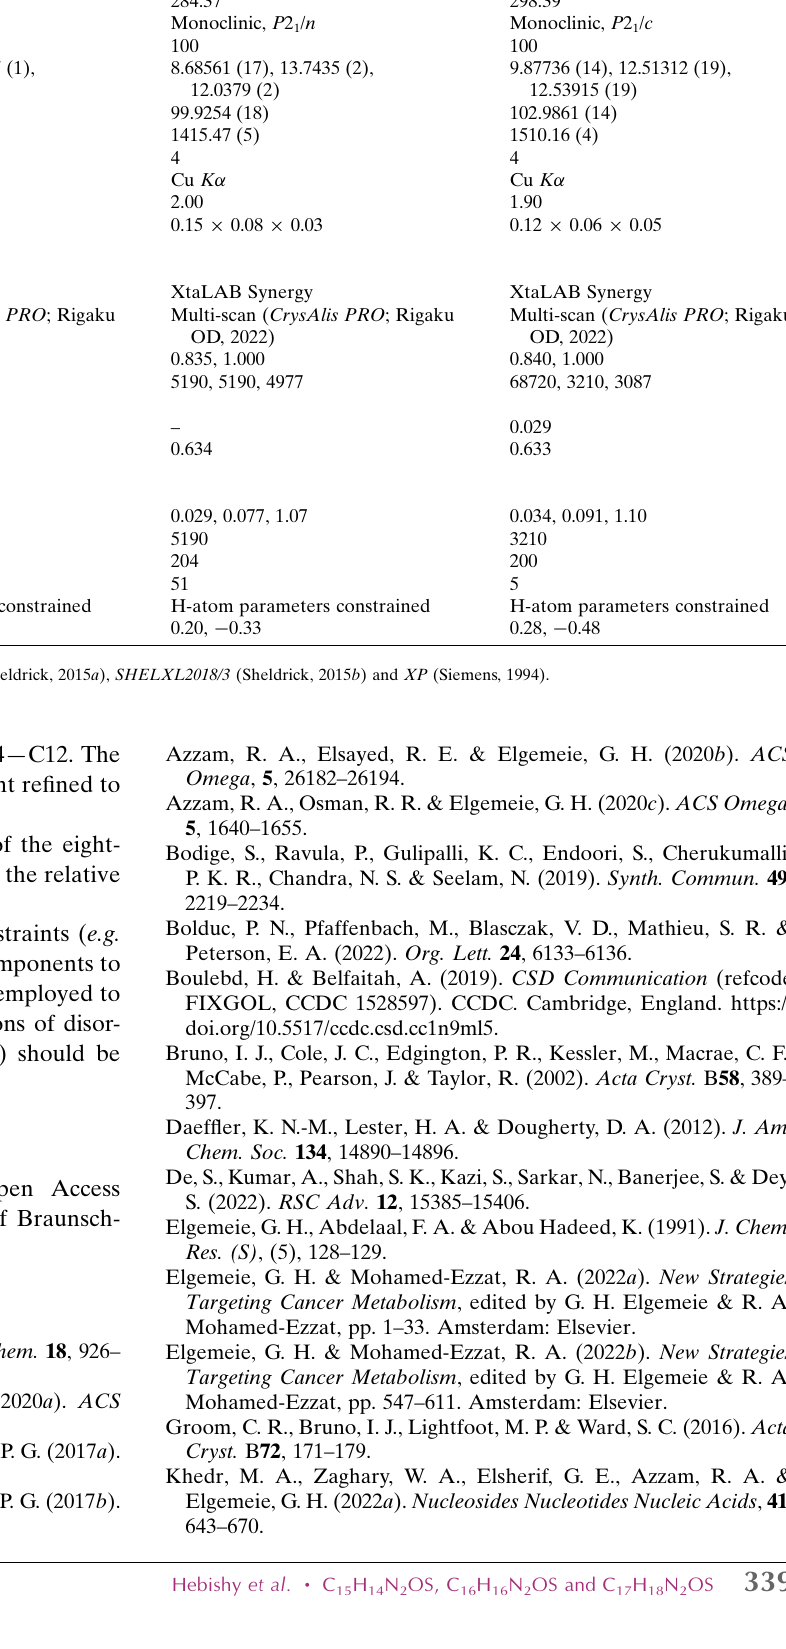
Crystal data Chemical